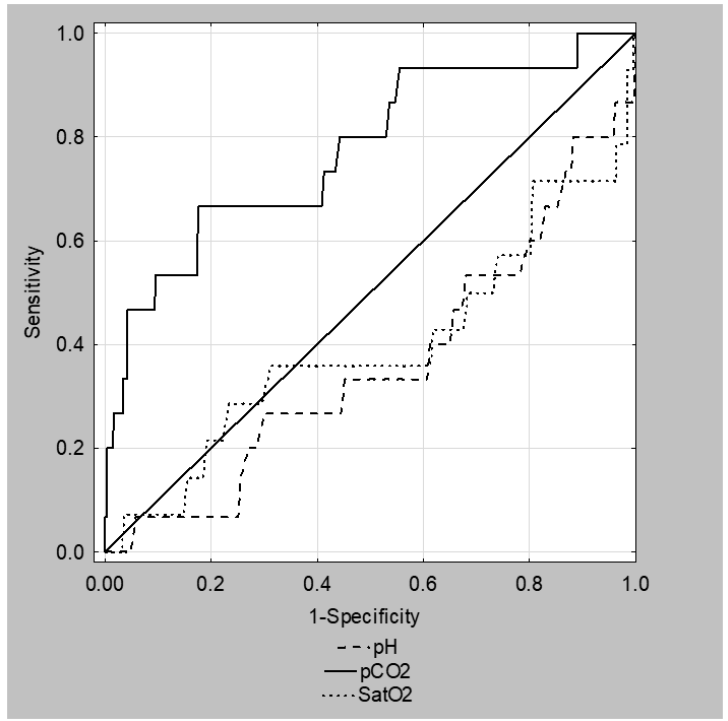
Figure 1. ROC curves for pH, pCO 2 , and SatO 2 in prediction of an ICU transfer.